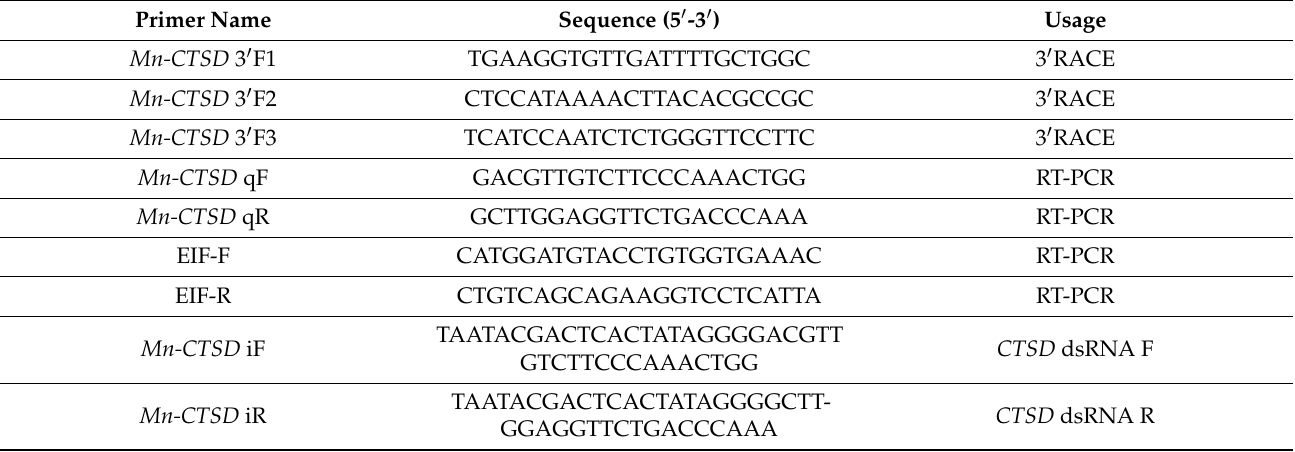
Table 3. Primers involved in this